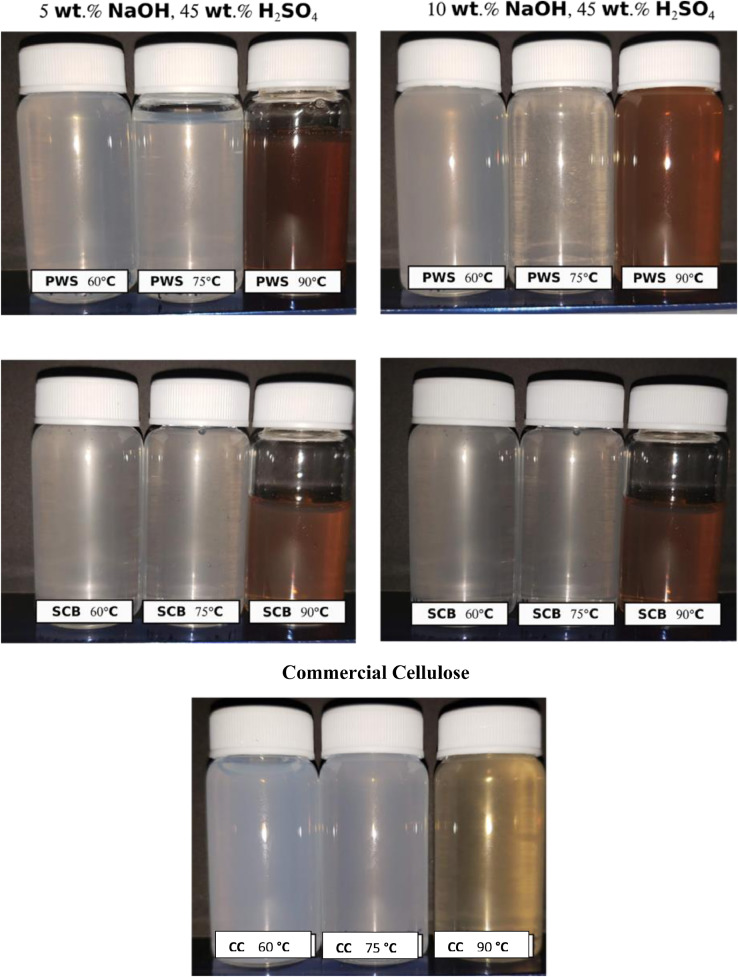
Photographic record of the nanocrystalline cellulose produced from agroindustrial wastes with 5 and 10 wt.%. NaOH, 45 wt.%. H2SO4 under different temperatures.